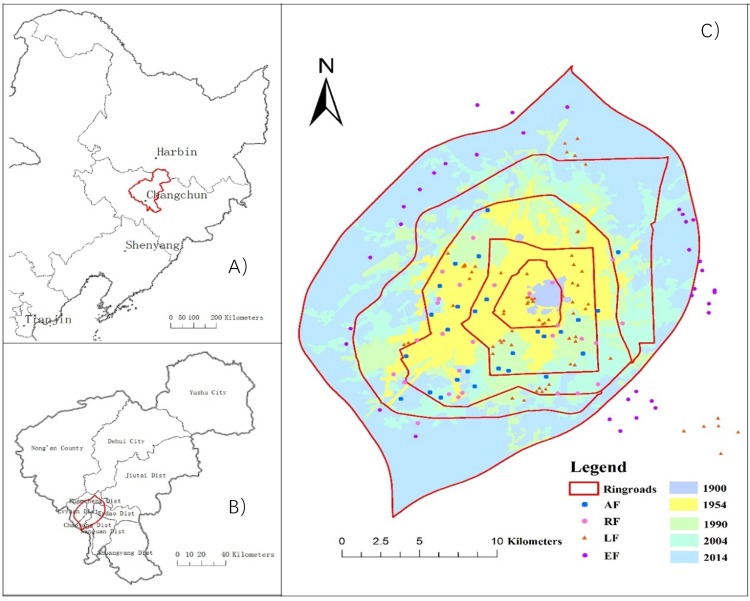
 Location of and sample sites in the study area.(A) The map of Northeast China, (B) the map of Changchun administrative region and (C) the map of study area, in which the shading represented the regions of different human settlement time and the red lines indicated the different ring road boundaries (from inner to outer matched the ringroad 1st to 5th regions). The map was created using ArcGIS 10.3 (Esri, Redlands, CA, USA; http://www.esri.com/software/arcgis).